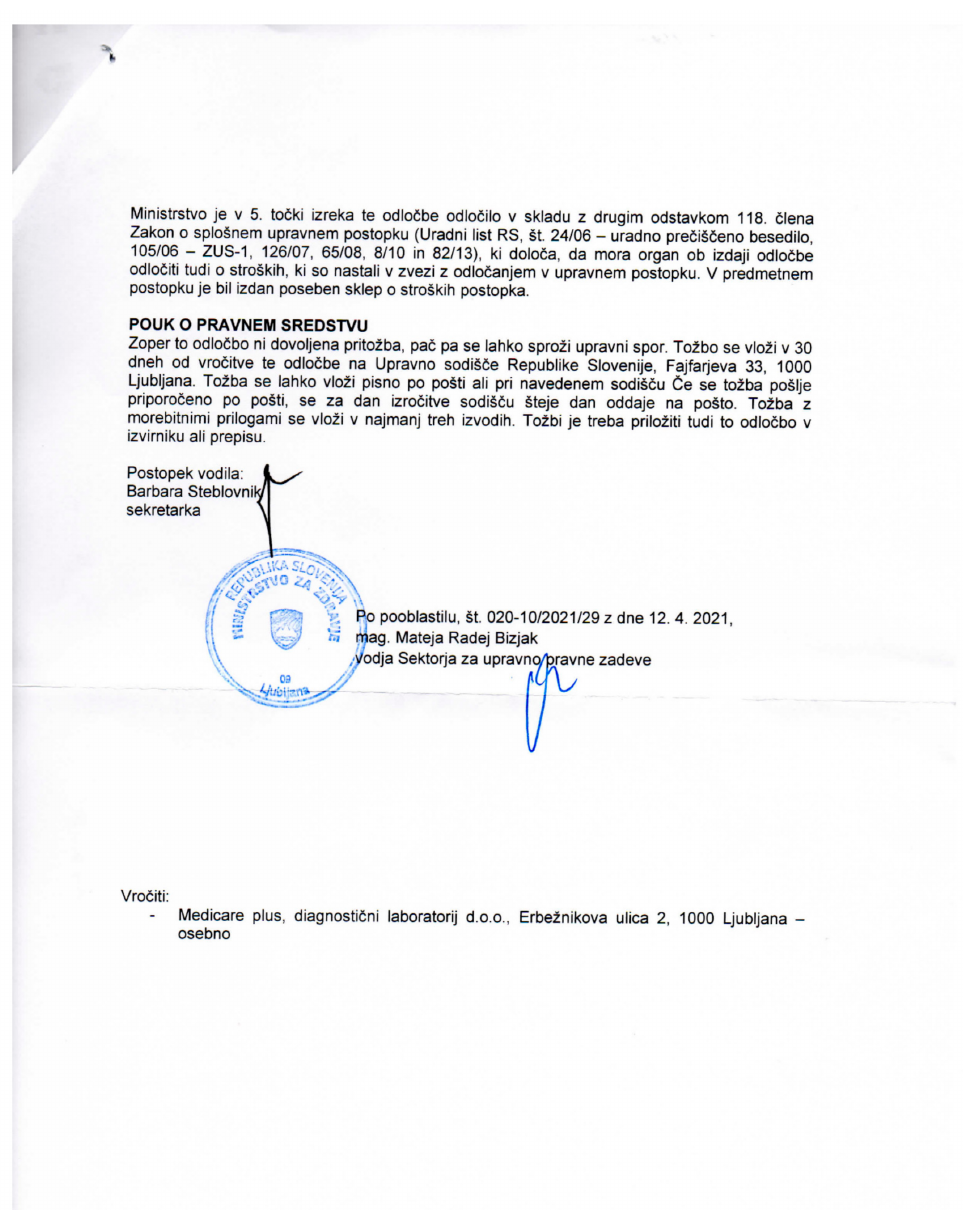
Figure A2. Permission to conduct research in the field of biochemistry from the Ministry of